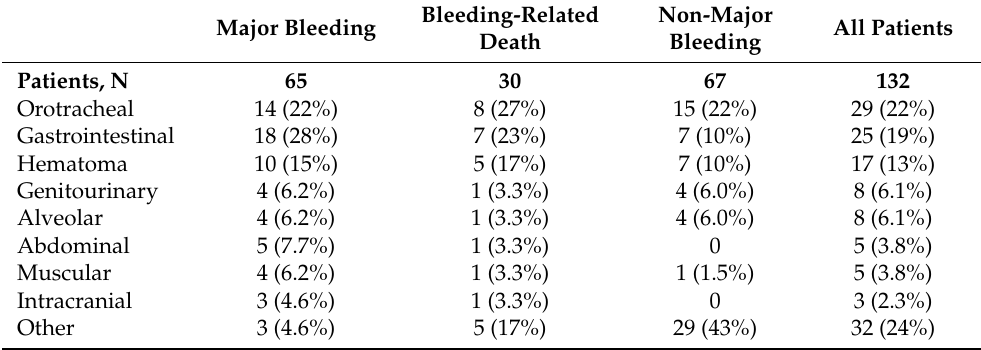
Table 3. Sites of